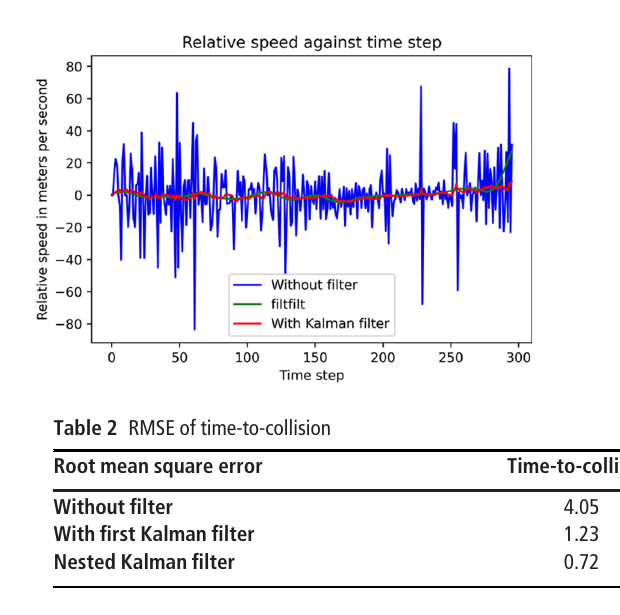
Figure 3 Relative distance and speed with Kalman fi lter